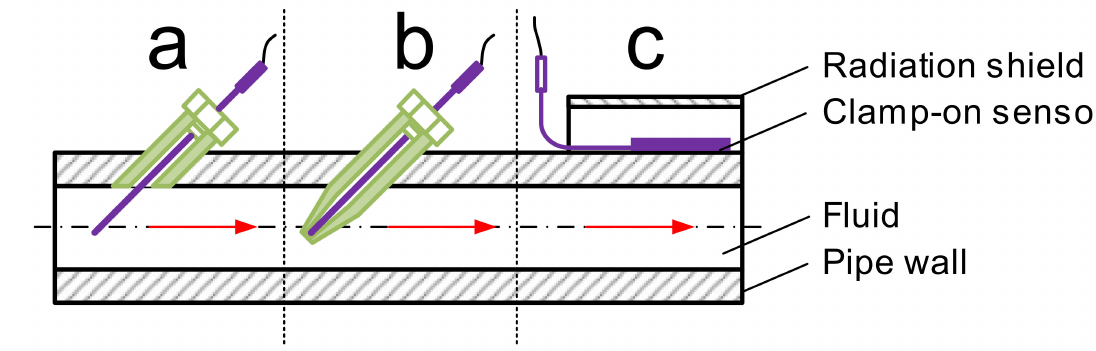
Figure 3. Temperature sensor installations shown without insulation, ( a ) wetted integration, ( b ) embedded installation, ( c ) clamp-on sensor, figure inspired by